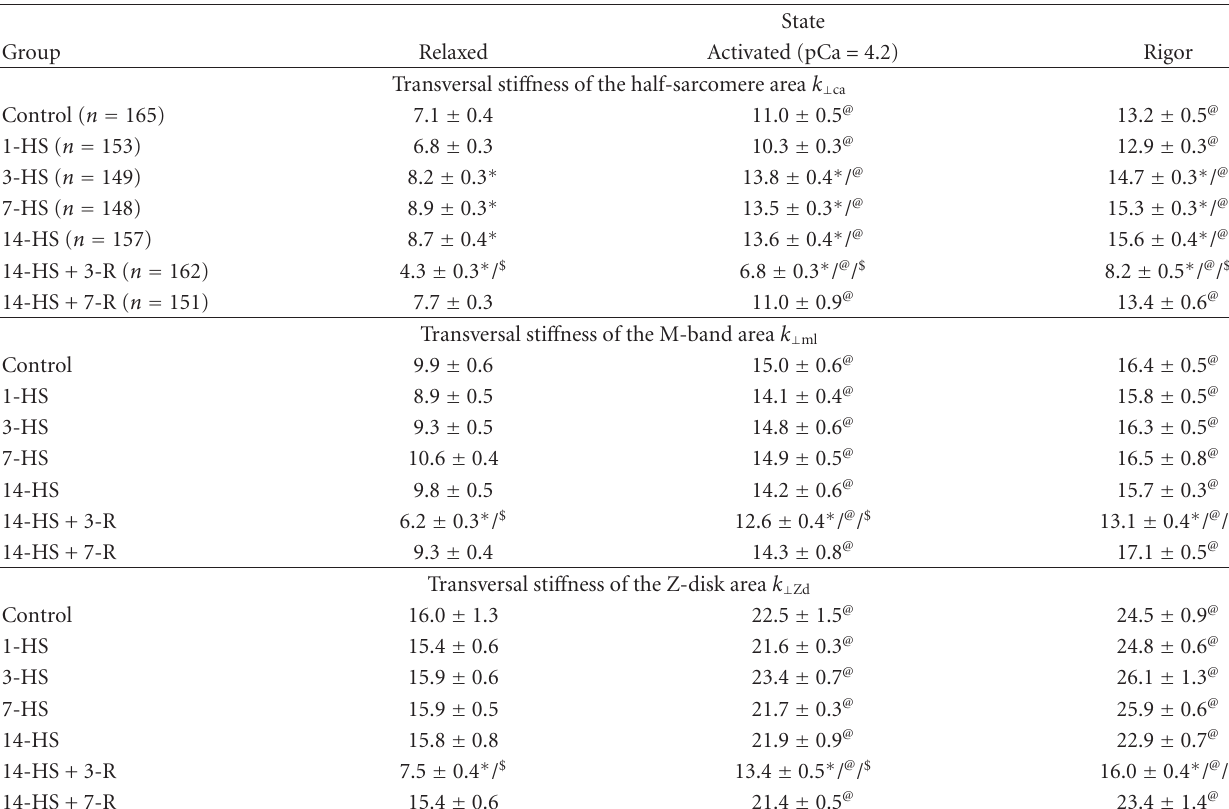
Table 1: Transversal sti ff ness (pN/nm) of isolated rat’s Triton-treated left ventricular myocytes in liquid in relaxed, calcium activated (pCa = 4.2) and rigor states under gravitational unloading and subsequent reloading.